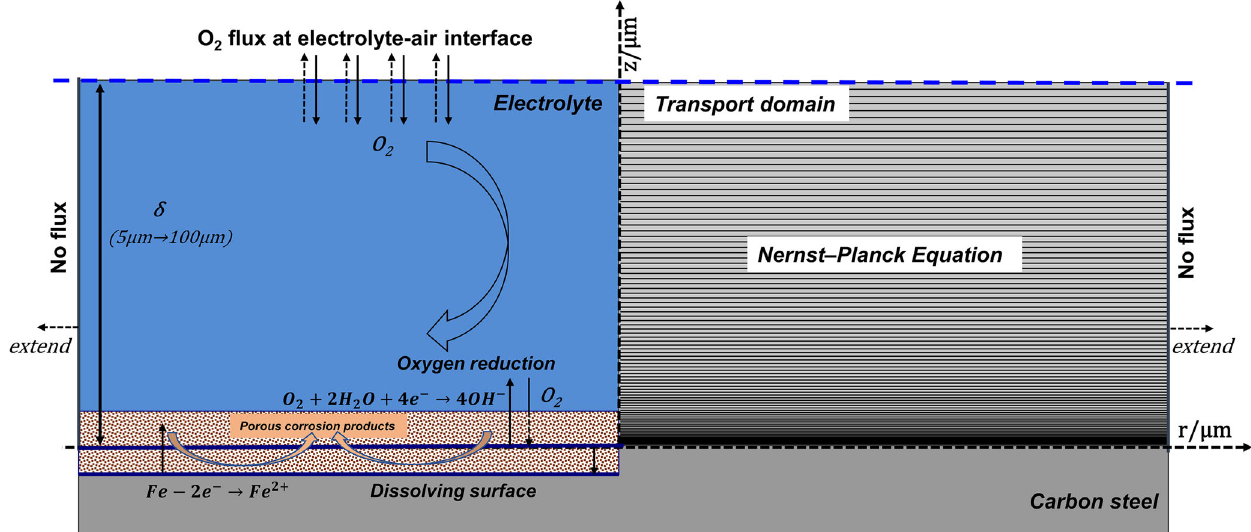
Fig. 1 Schematic diagram of the FEM model of atmospheric corrosion under thin electrolyte fi lm. Left: the physical process. Right: The